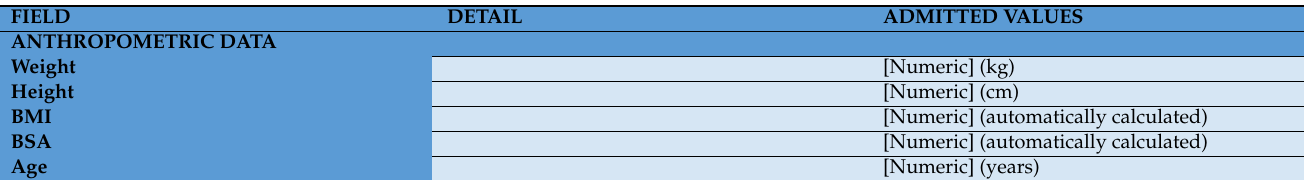
Table A8. PATIENT’S CLINICAL DATA (imported from